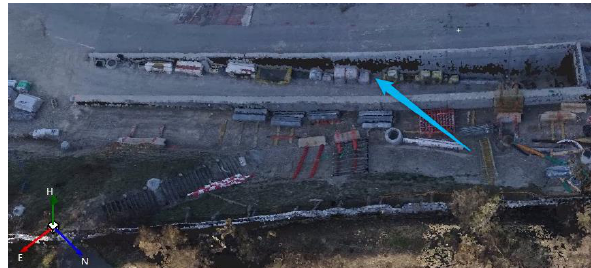
Figure 7 . Example of missing data in a narrow driveway due to